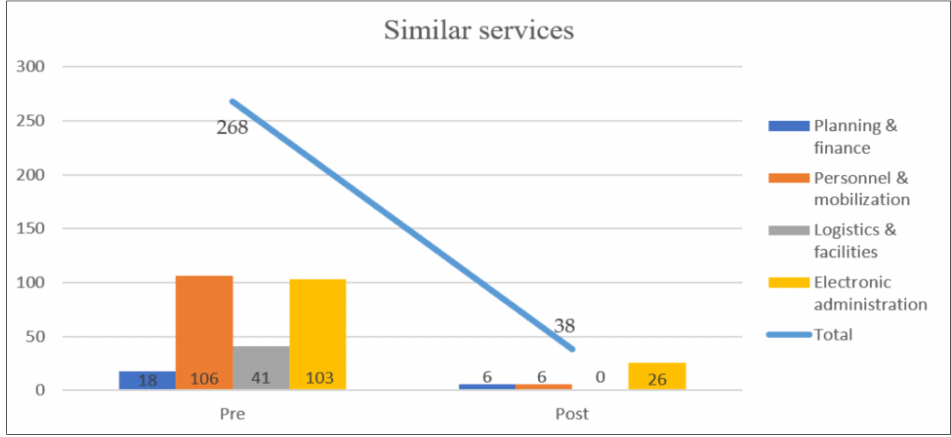
Figure 10. Similar services after applying